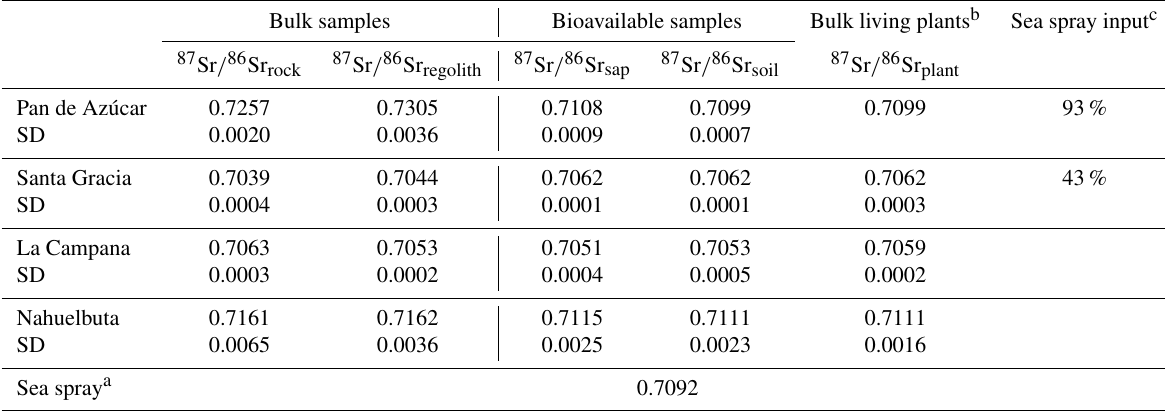
Table A2. Average 87 Sr / 86 Sr ratio for bulk bedrock, bulk regolith, and the bioavailable fraction in saprolite and soil. 87 Sr / 86 Sr in bulk plants are weighted by the plant organs’ relative growth rate and relative species abundance in the respective ecosystem (see Table 4). Radiogenic Sr composition for each single specimen is reported in Data Tables S2 (bulk regolith samples), S3 (bioavailable fraction of saprolite and soil), and S5 (plant samples).